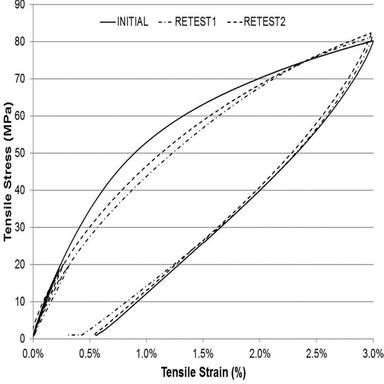
Sample behaviour with 10 wt% microcapsules at initial, retest and self-healed retest stages.